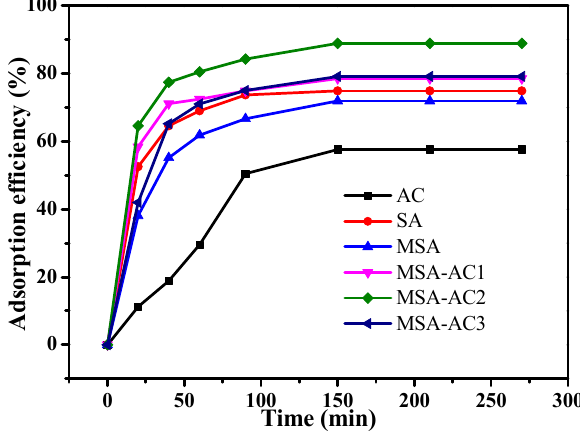
Figure 7. The adsorption capacities of different magnetic spheres over time.